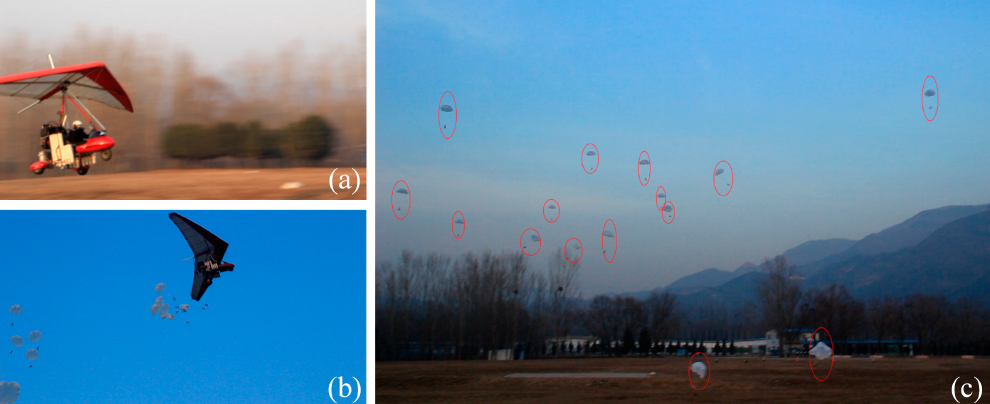
Figure 13. Deployment process of the integrated experiments: ( a ) The airplane took off from the ground. ( b ) The airplane deployed robots from the air. ( c ) Experimental scene of deployment.